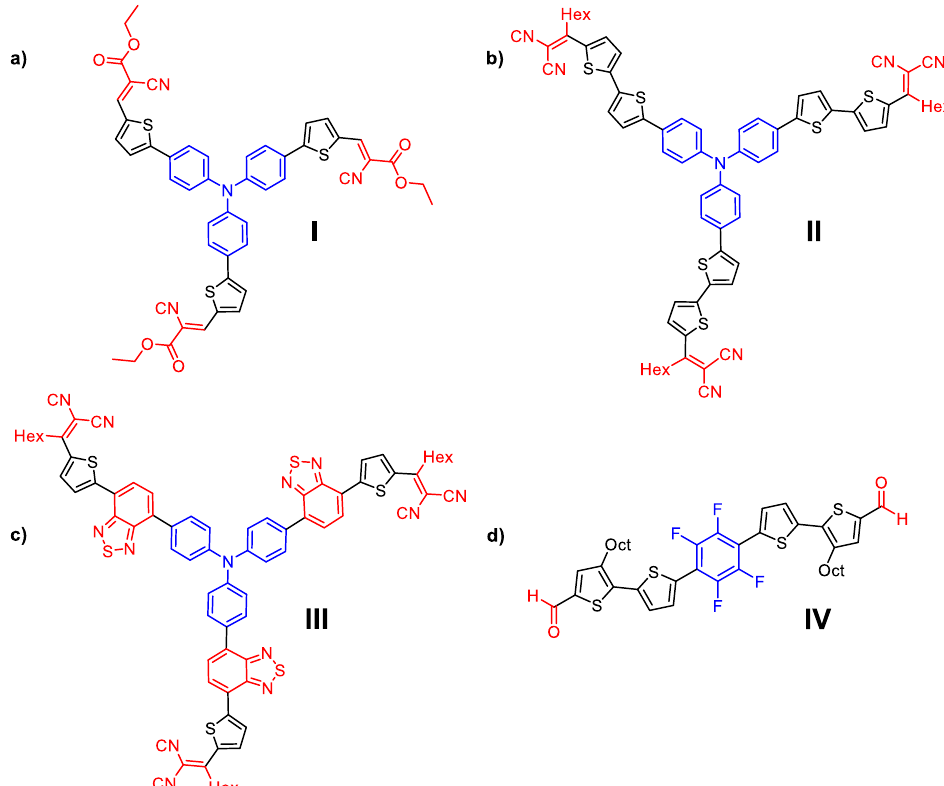
Figure 2. Chemical structures of molecules I – IV that mimic human photoreceptors, as follows: ( a ) rods, ( b ) green-sensitive cones, ( c ) red-sensitive cones, and ( d ) blue-sensitive cones.